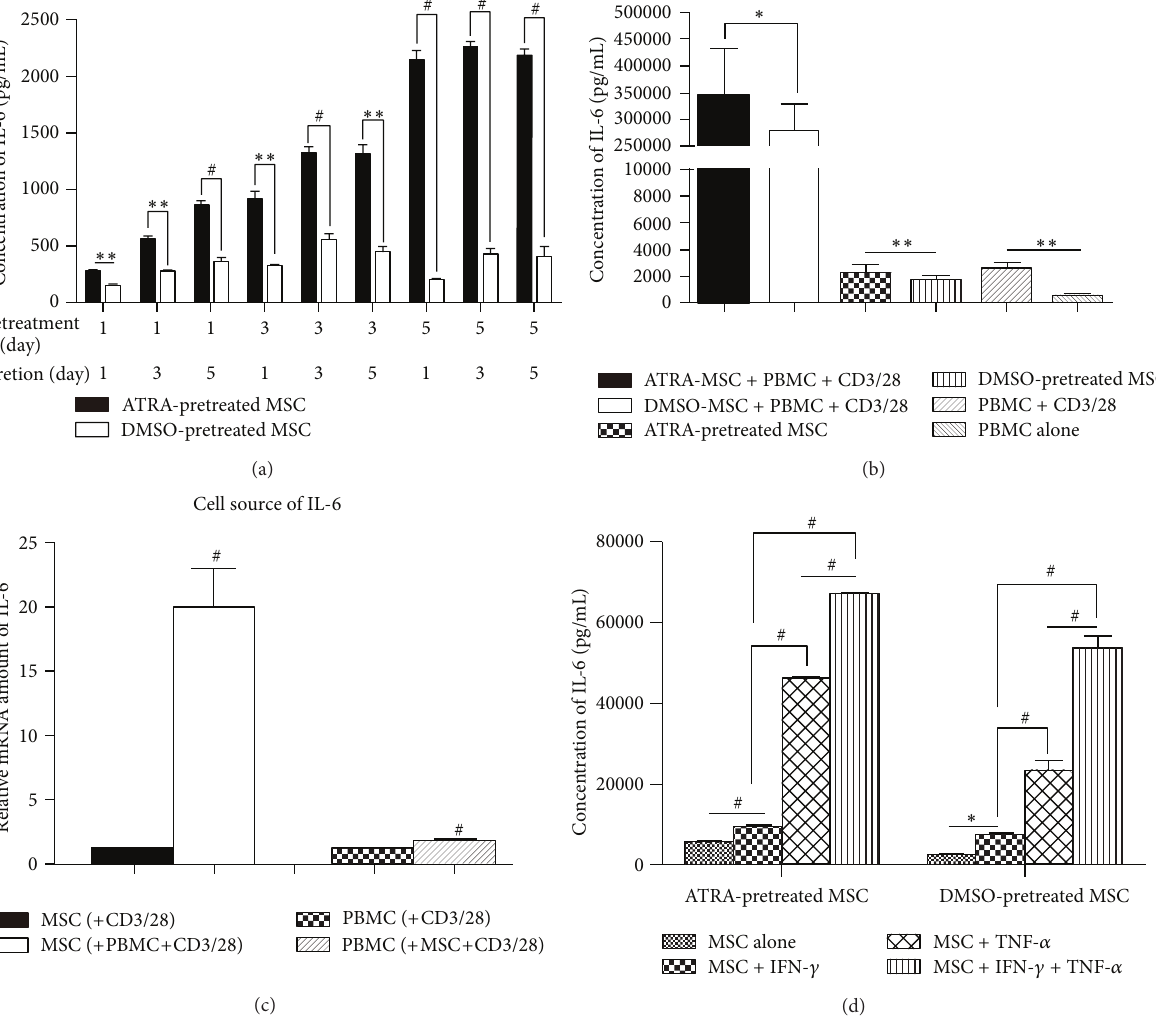
Figure 4: Changes of IL-6 levels under different conditions. (a) Concentration of IL-6 secreted by MSCs pretreated for different durations (1 day, 3 days, and 5 days). The secreting durations (1 day, 3 days, and 5 days) after pretreatment were different, too. Paired 𝑡 -test was used. (b) Concentration of IL-6 in coculture and noncoculture groups. Paired 𝑡 -test was used. (c) Relative mRNA amount showed the principal cell source of IL-6. (d) Effects of IFN- 𝛾 and TNF- 𝛼 on production of IL-6 by MSCs. One-way ANOVA was used. ∗ 𝑃 < 0.05 , ∗∗ 𝑃 < 0.01 , and # 𝑃 < 0.001